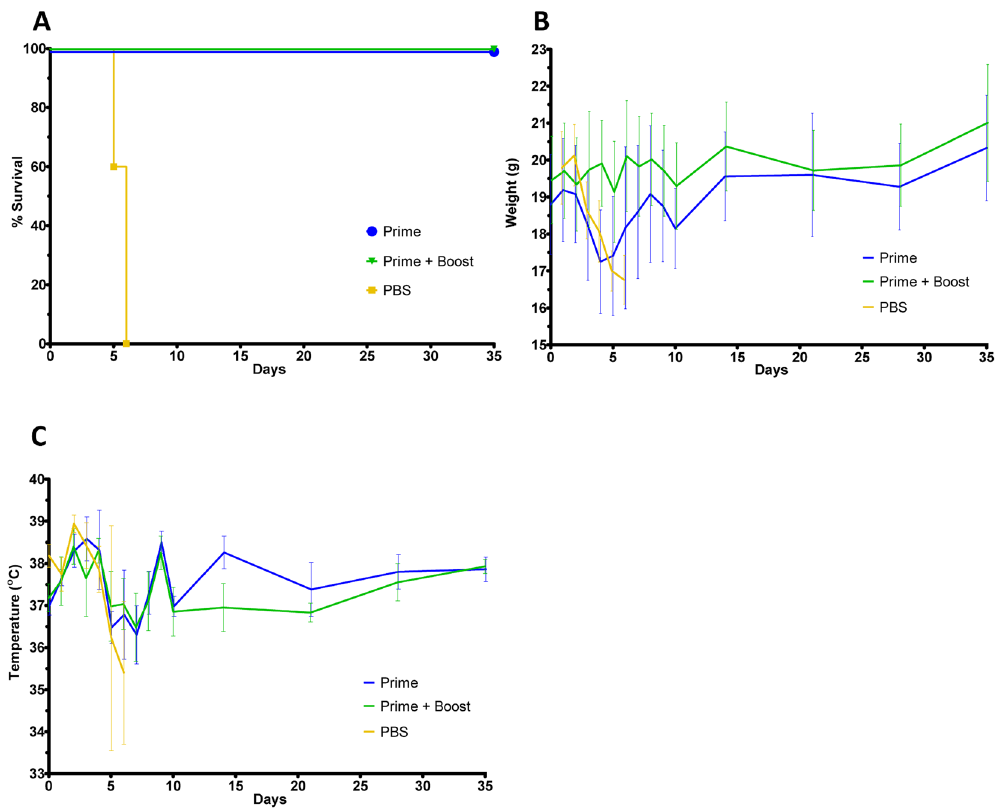
Figure 4. In vivo experimental data: animal survival, average weights, average temperatures, and clinical scoring. ( A ) Kaplan-Meier survival curve of challenged animal groups. Group is indicated by color which corresponds to the colored triangles outlined in Fig. 3. ( B ) Averaged weights with error bars from all groups collected each day for 14 days post challenge and every 7 days after that for 35 days post challenge total. ( C ) Averaged temperature with error bars from all groups collected each day for 14 days post challenge and every 7 days after that for 35 days post challenge